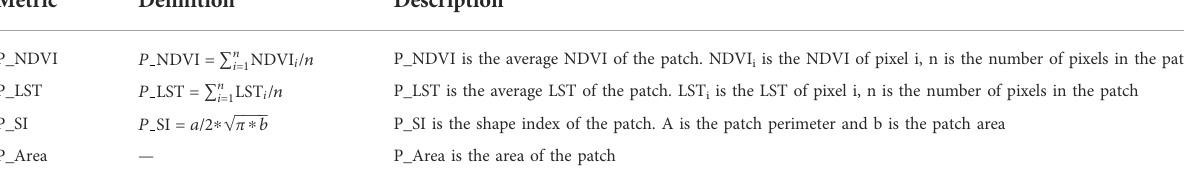
TABLE 3 Landscape metrics of the urban green space